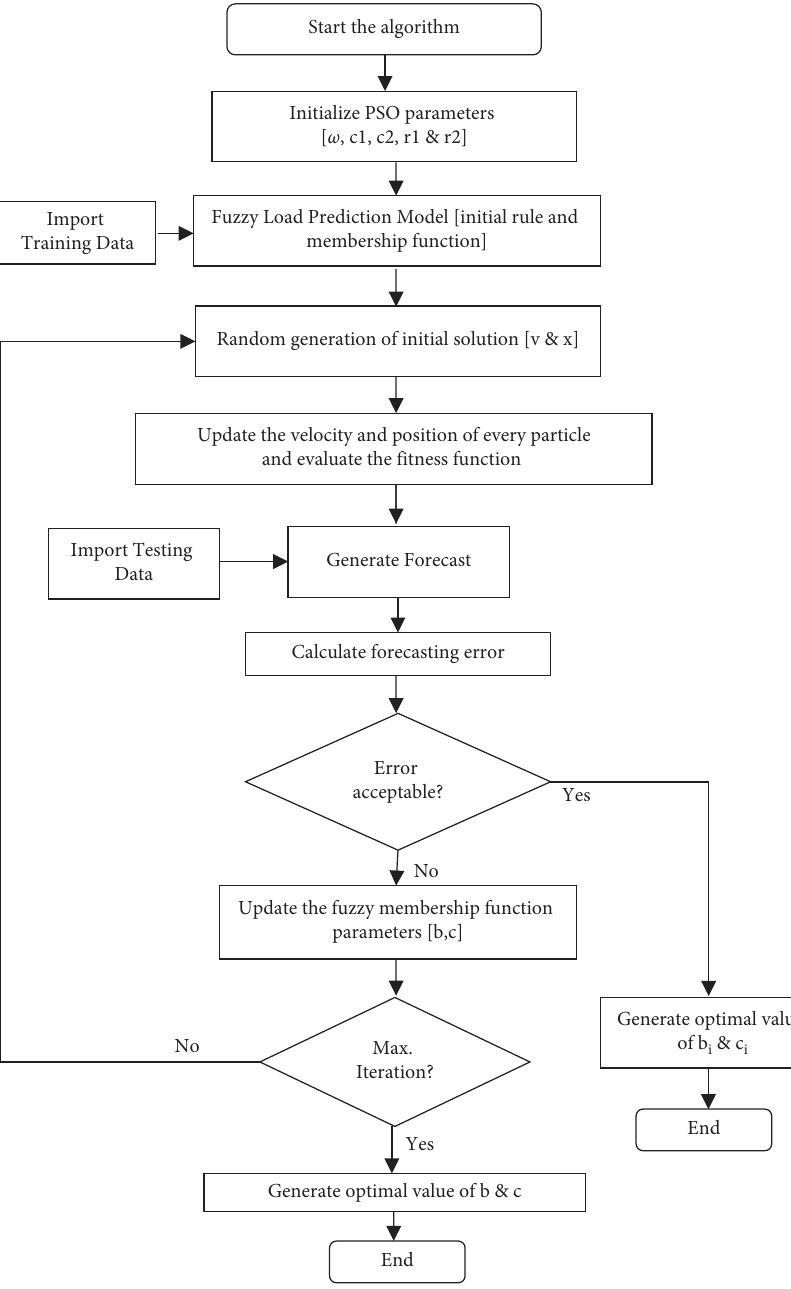
Figure 11: Fuzzy-PSO tuning process for load prediction.